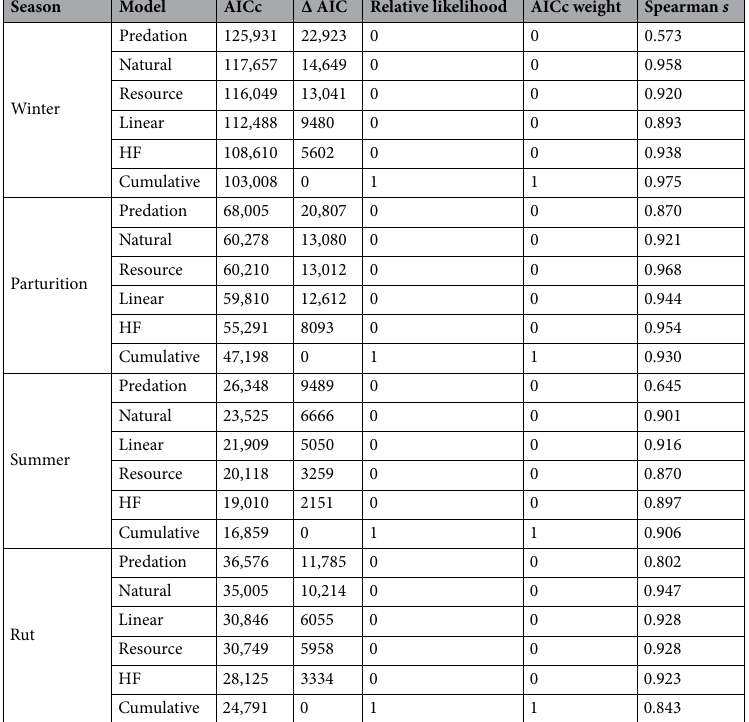
Table 3. Akaike Information Criteria correction (AICc) results, including change in AICc and corresponding AICc weight, for each model during each of the four deer seasons: winter, parturition, summer and rut. Spearman s is the mean value based on k-fold cross validation where k =